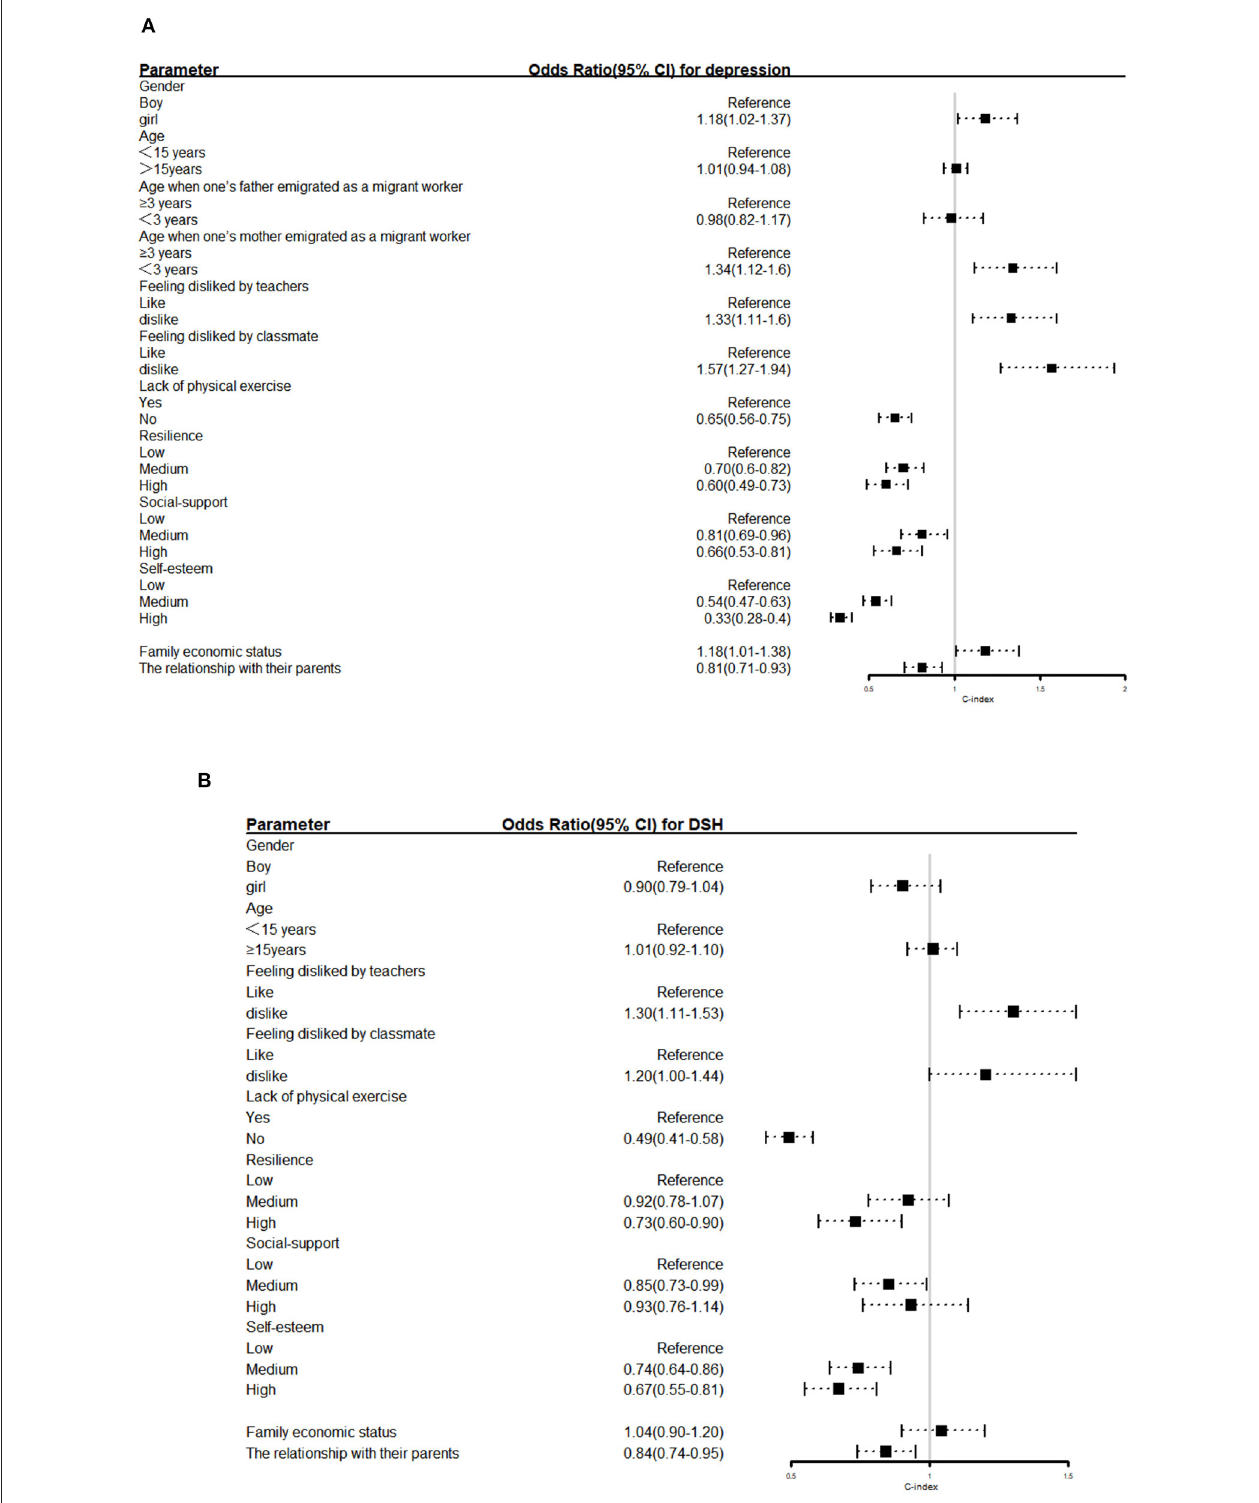
FIGURE 2 | Odds ratios for (A) depression and (B) deliberate self-harm(DSH). The horizontal lines represent the 95% confidence interval (CI).